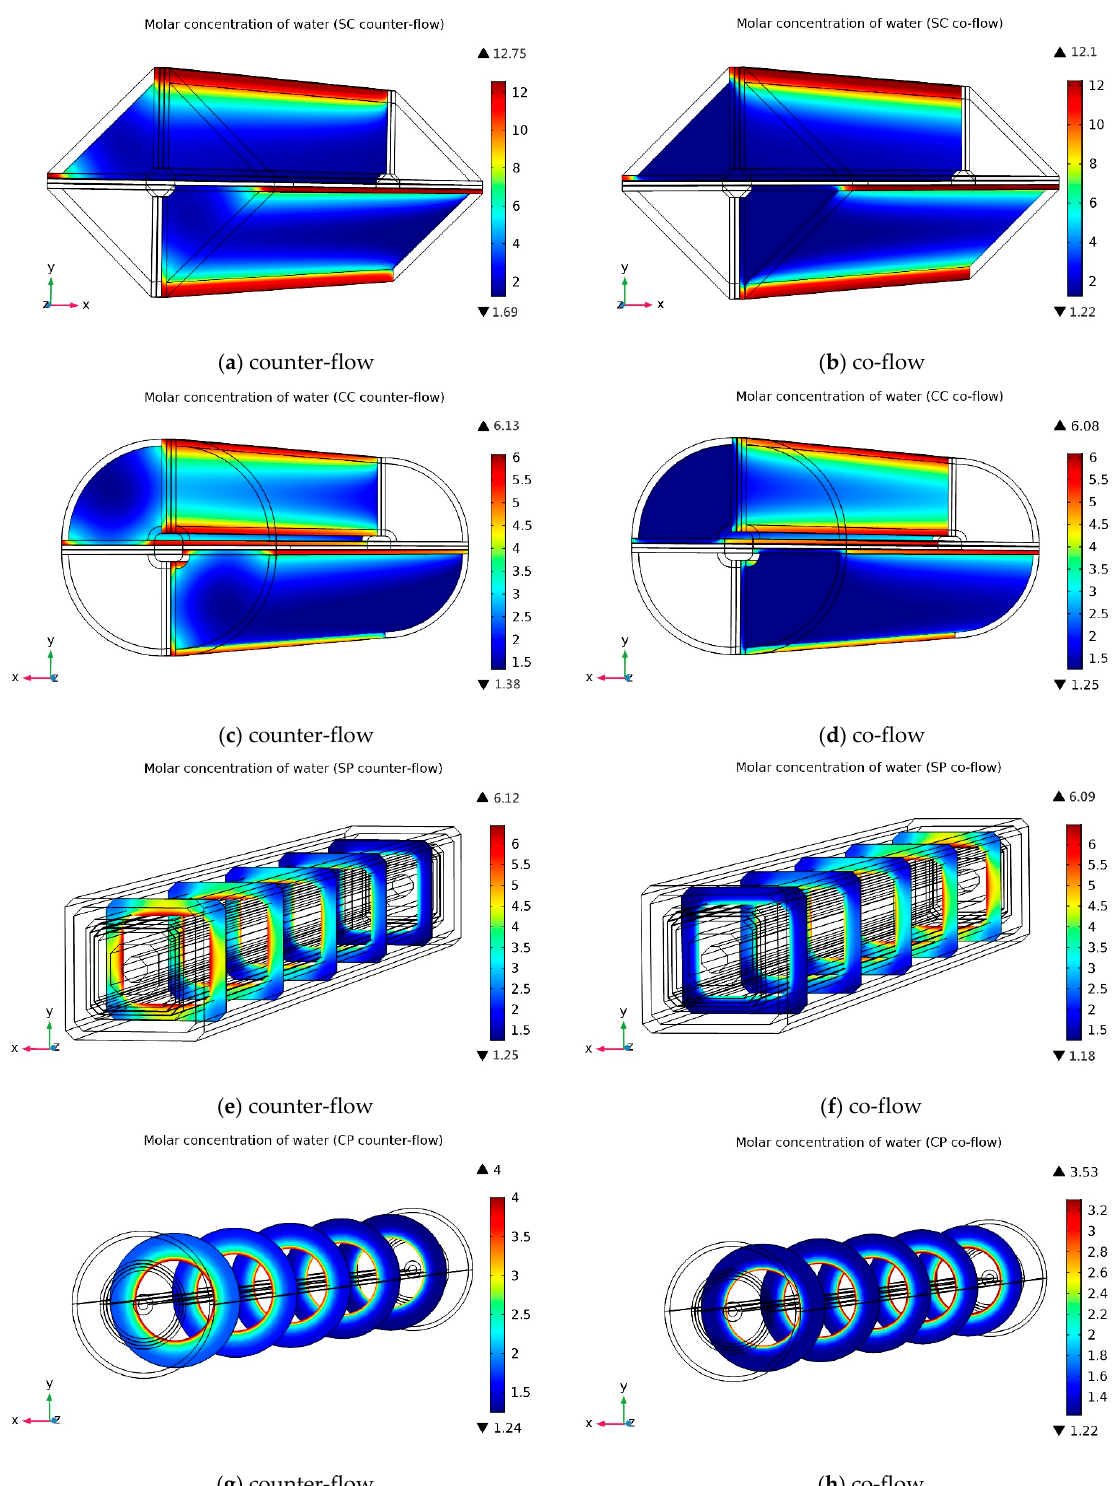
Figure 6. Molar concentration distribution diagram of water(mol/m 3 ) at V = 0.4